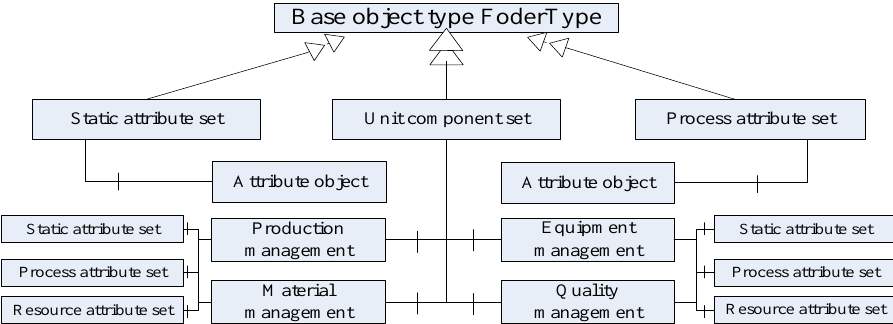
Figure 8. Mapping method of lithium ion battery intelligent manufacturing workshop information model and OPC UA address space.